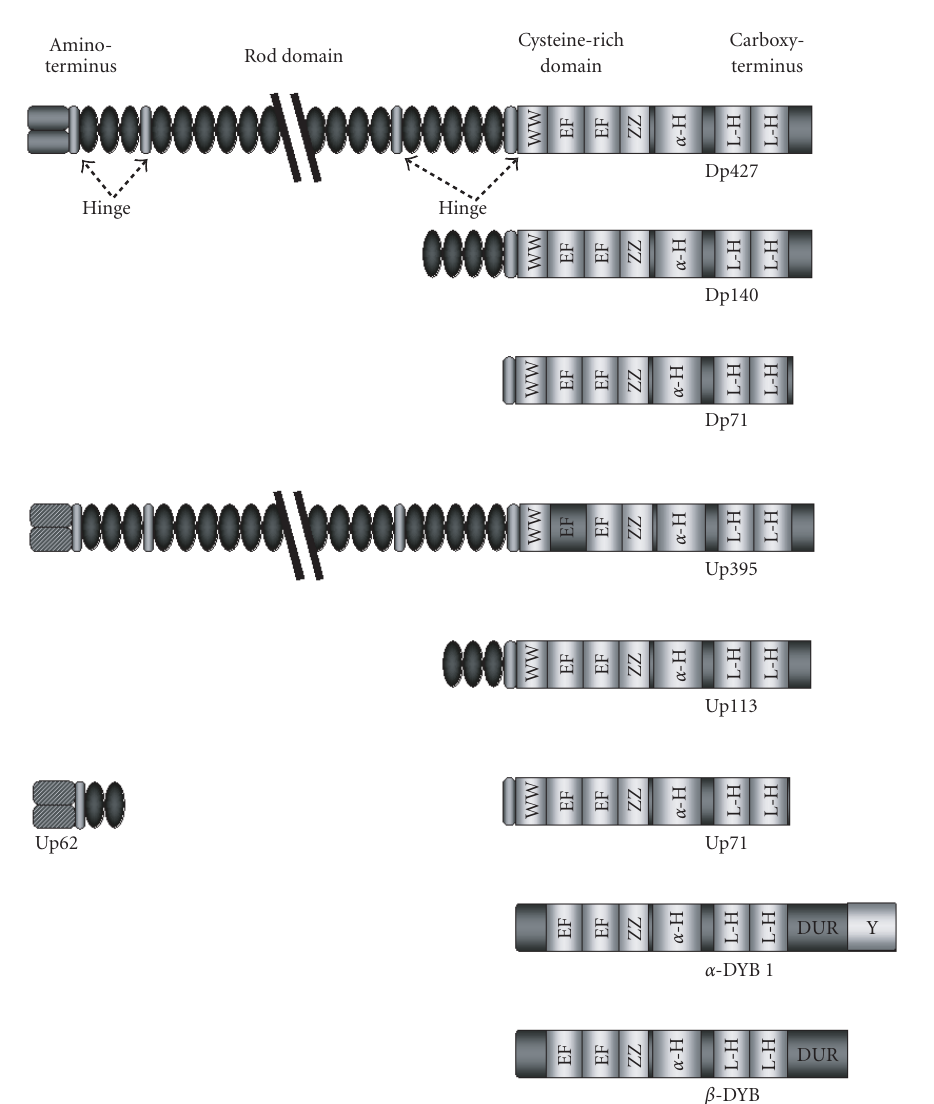
Figure 1. Dystrophin and the dystrophin-related proteins specific to brain. Schematic representation of dystrophin and the dystrophin-related proteins, and the similarities shared by each protein. Shown are the four distinct regions of dystrophin: the amino-terminus, the rod-domain interrupted by the four proline-rich hinge regions, the cysteine-rich domain, and the carboxy-terminus. Abbreviations used: Hinge: hinge regions, Cysteine: cysteine-rich domain, WW: PPxY-binding WW motif, EF: Ca 2+ -dependent twin EF-hand motifs, ZZ: Zn 2+ -dependent zinc fingers, α -H: α -helical domain, L-H helical leucine heptads which makeup the coiled-coil domain, DUR: dystrobrevin-unique region, Y: region of tyrosine